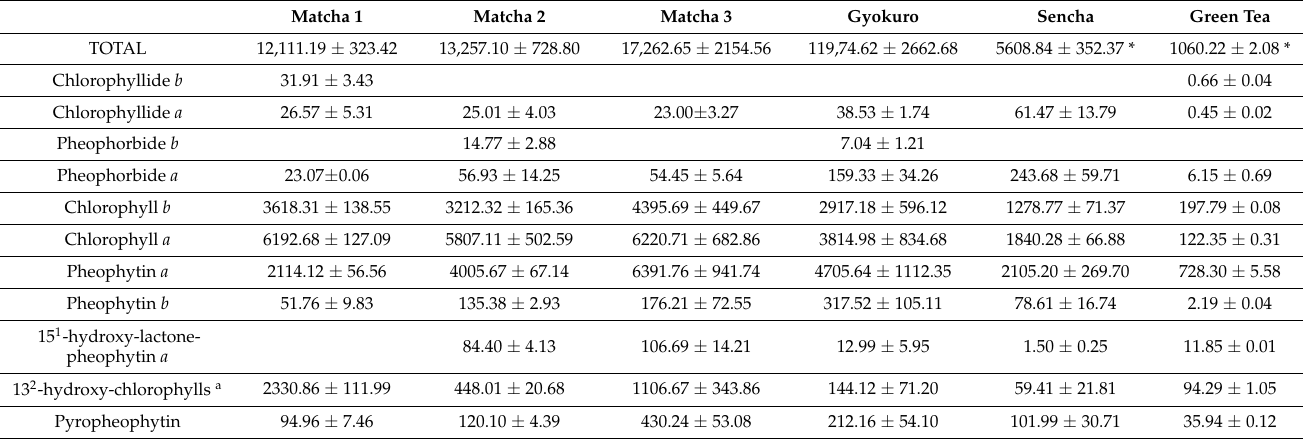
Table 2. Chlorophyll profile in green teas (mg/Kg dw ± SD). Matcha